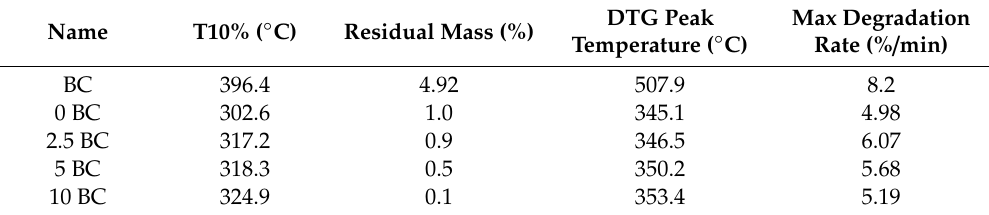
Table 5. Results of TGA analysis for composites and biochar examined in air atmosphere.